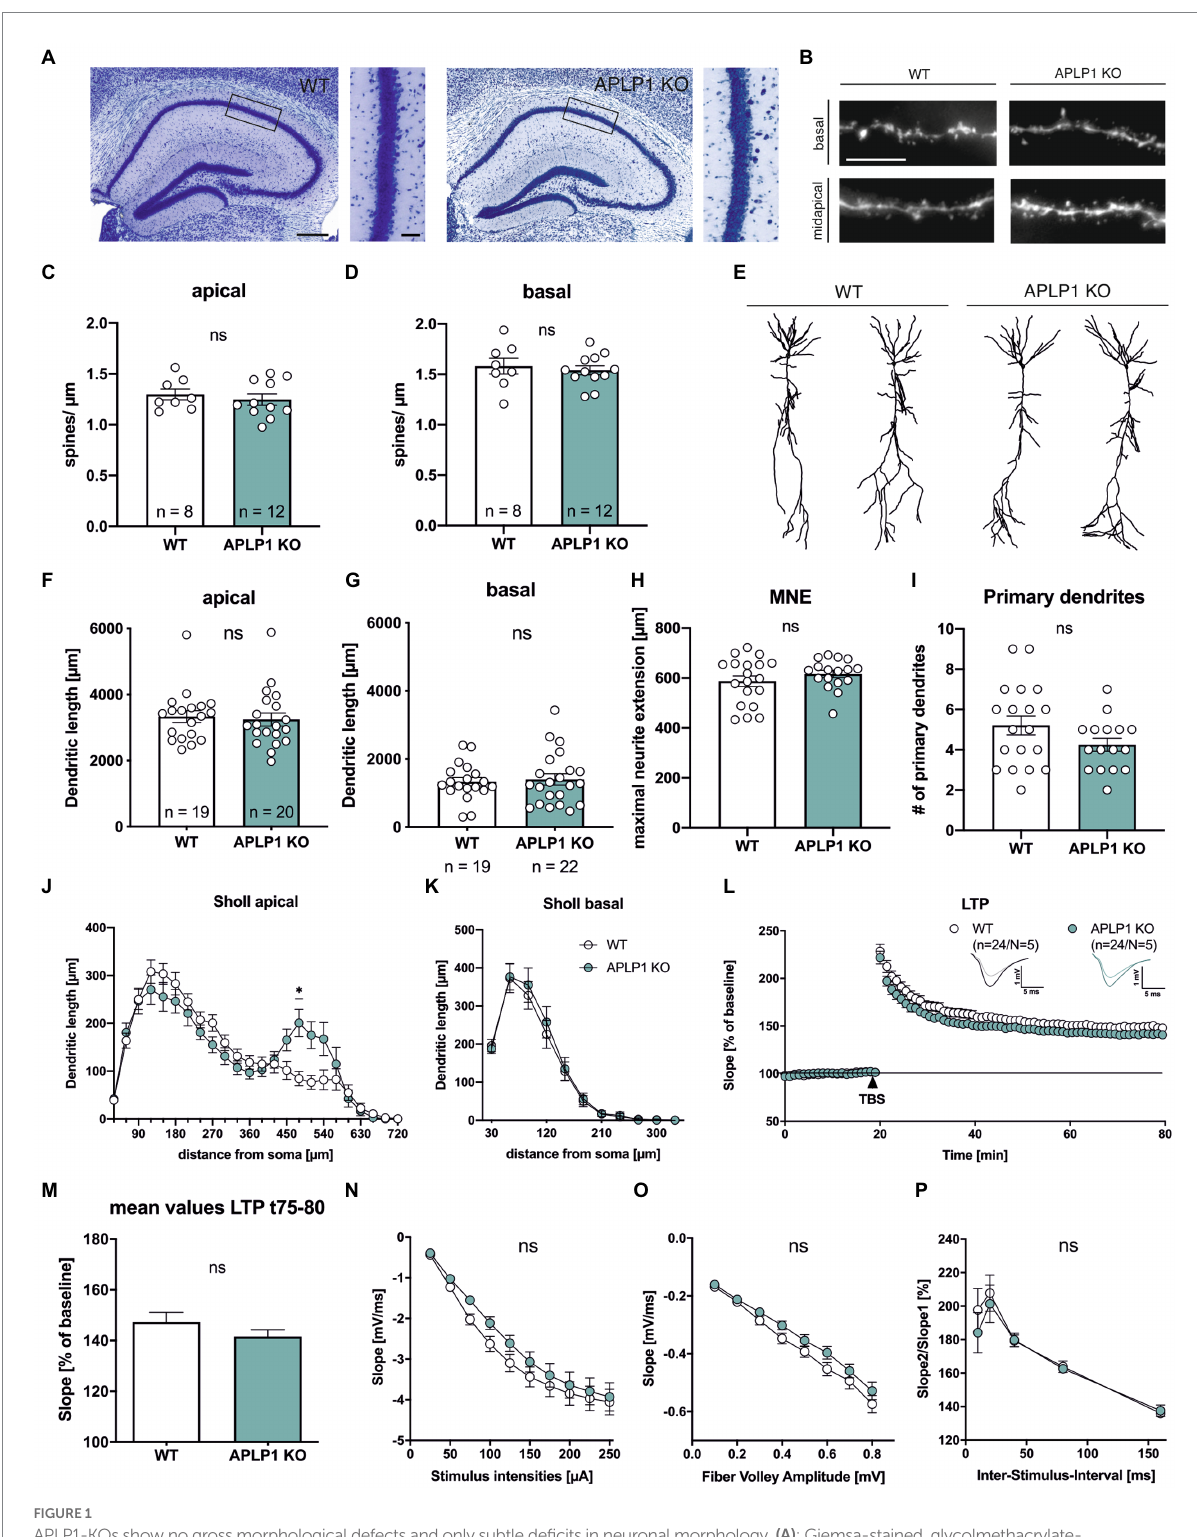
FIGURE 1 APLP1-KOs show no gross morphological defects and only subtle deficits in neuronal morphology. (A) : Giemsa-stained, glycolmethacrylate- embedded coronal brain sections (bregma − 1.9) displaying the hippocampus and adjacent callosal fiber tracts of a wildtype WT, left and a APLP1-KO (right; age: 5–6 months). Scale bar: 200 μ m, close-up: 50 μ m. (B) : Representative images of basal and midapical dendritic segments. Brightness and contrast were adjusted to ensure a uniform appearance. Scale bar: 5 μ m. (C, D) : Spine density of CA1 pyramidal cells is not significantly altered in midapical dendritic segments (C; unpaired Student’s t -test, ns p = 0.5306), as well as in basal dendritic segments (D; unpaired Student’s t-test, ns p = 0.6281). (E) : Representative 3D reconstructions of CA1 pyramidal neurons from both genotypes. (F) : Compared to wildtype controls, CA1 neurons of